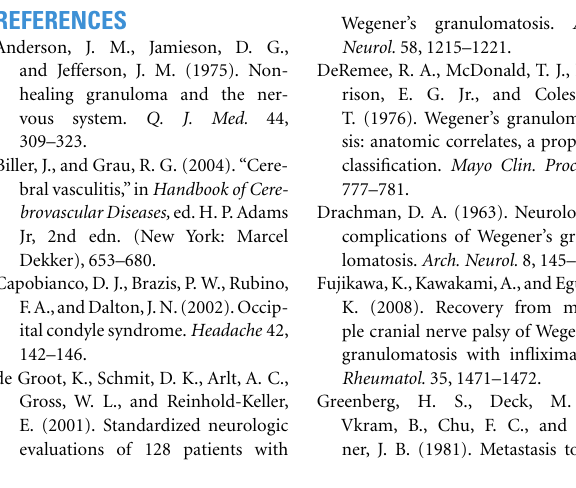
condyle syndrome, first identified by Greenberg et al. (1981). The occipital condyle syndrome has been associated with metastases to the base of the skull and primary head and neck tumors (Green-